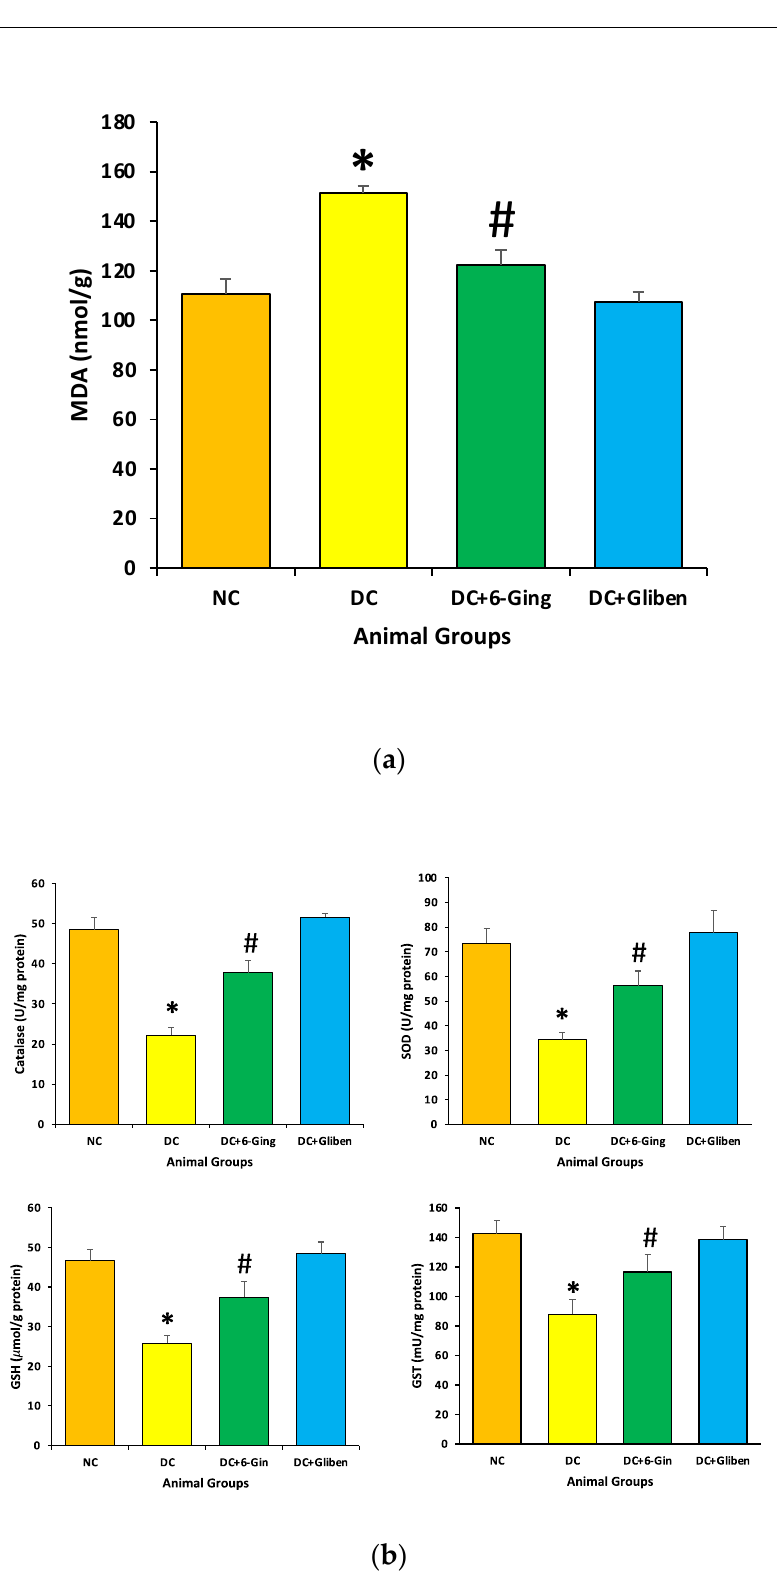
Figure 4. ( a, b ): The lipid peroxidation (MDA) and antioxidant enzyme (CAT, SOD, GST and GSH) level in different groups of rats after 8 weeks of treatment. The rats were equally divided into 4 groups, each group (sample size = 8). Data are shown as mean ± standard error of the mean (SEM). Groups: Normal control (NC); disease control (DC), i.e., STZ-treated group; treatment group (DC + 6-gingerol); positive control (PC) animal treated with STZ + glibenclamide; * p < 0.05 (significant difference of final b.w. between DC vs. NC) # p < 0.05 (significant difference of final b.w. between DC vs. DC + 6-gingerol).